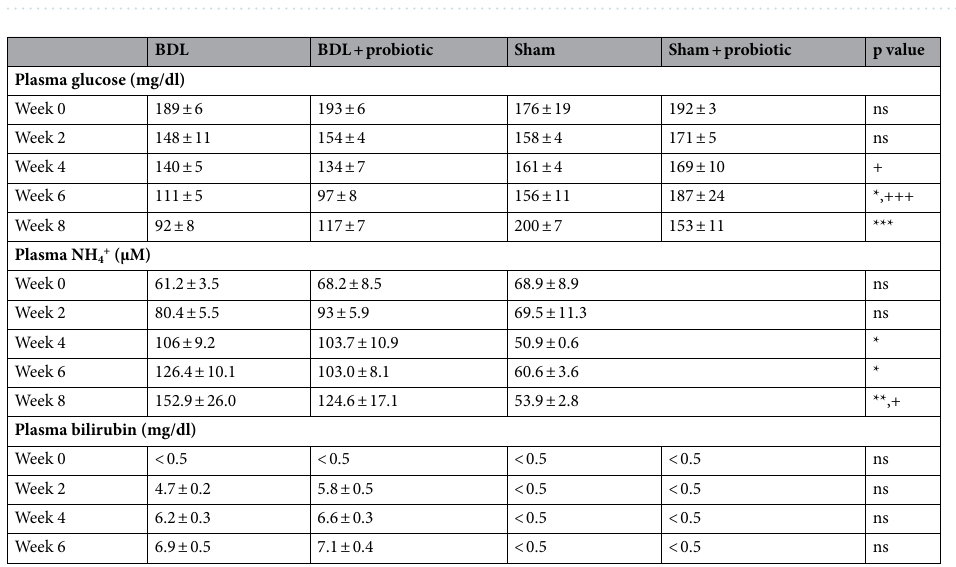
Table 2. Evolution of plasma glucose, NH 4 + and bilirubin in BDL, BDL + probiotic, sham and sham + probiotic animals during disease progression. Plasma NH 4 + showed no difference between shams and shams + probiotic. Therefore, we pooled them together for the analysis. P value: for plasma glucose and plasma NH 4 + , one-way ANOVA with Bonferroni correction, *significance between BDL and sham groups, + significance between BDL + probiotic and sham groups. ns non-significant. For plasma bilirubin, one-way ANOVA with Bonferroni correction statistics are shown between BDL and BDL +